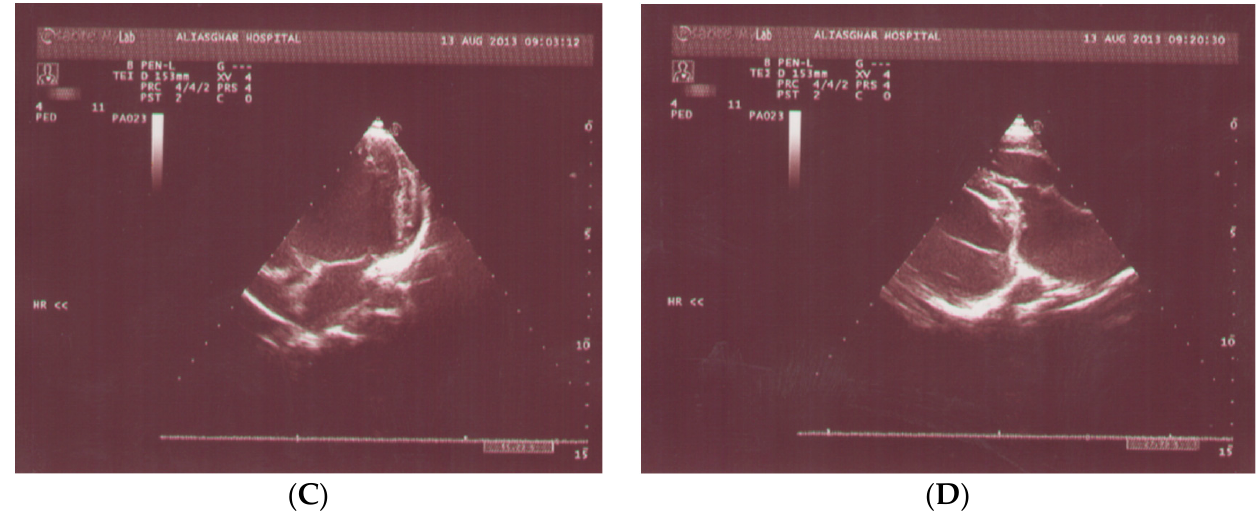
Figure 2. Echocardiography showed an abnormal mass in the posterior wall of the left ventricle. ( A ) Parasternal Short Axis view. ( B ) Left ventricle pericardial cyst. ( C ) Parasternal Long Axis view. ( D ) Apical 4-chamber view.